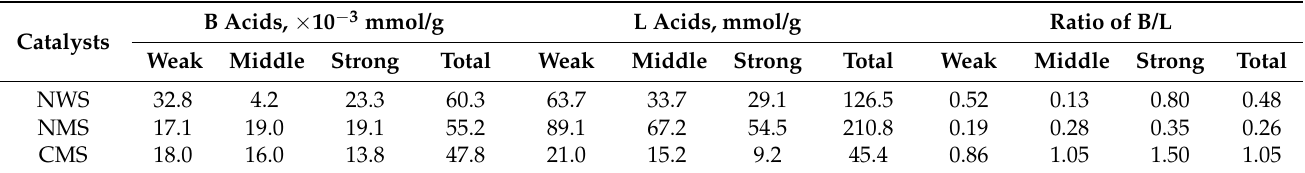
Figure 6. Acidic sites of the NiMo/AZ and NiW/AZ before and after sulfurization. ( a ) Bronsted acid; ( b ) Lewis acid. Table 2. Acidic sites of the NiMoS/AZ, NiWS/AZ, and CoMoS/AZ catalysts.